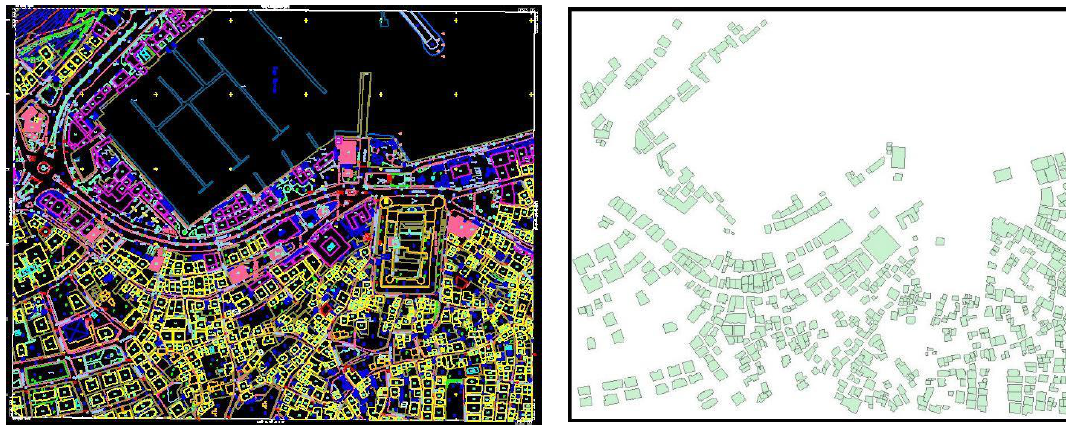
Figure 7. A part of the basemap with all CAD layers ( left ) and the building footprints extracted from a set of them ( right ).